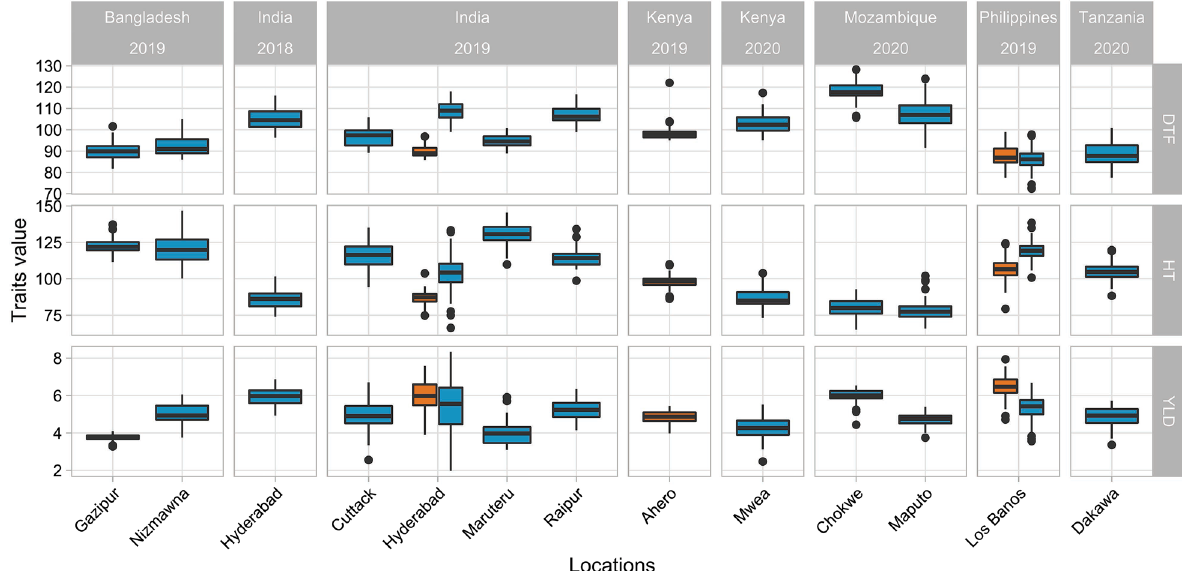
Fig. 2 Distribution of phenotypic values of elite lines for the three traits evaluated across the 15 environments. DTF days to flowering; HT plant height; YLD grain yield. The boxes with orange colors indicated the trials conducted in the dry season, and the boxes with the blue color indicated the trials in the wet